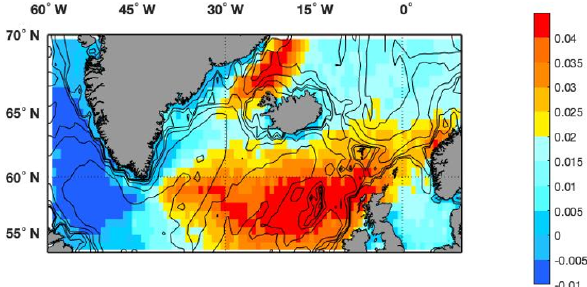
Figure 10. Mode 1 EOF winter (DJFM) gale days for North At- lantic. Based on ERA-Interim daily averaged 10m wind speed and the WMO gale definition of wind speed exceeding 17.2ms − 1 . Bathymetry contours from GEBCO bathymetry (http://www.gebco. net/, last access: 24 July